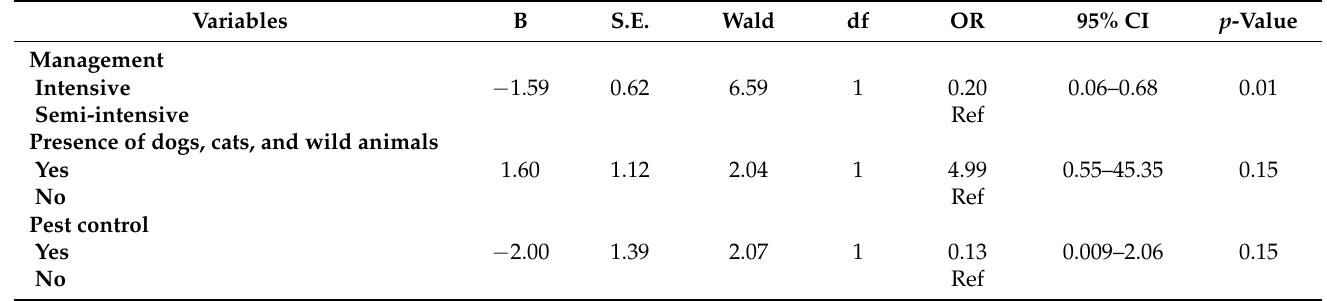
Table 5. Final mixed-effects logistic regression model of the factors associated with the prevalence of T. gondii antibodies in cattle from 16 farms in Selangor,